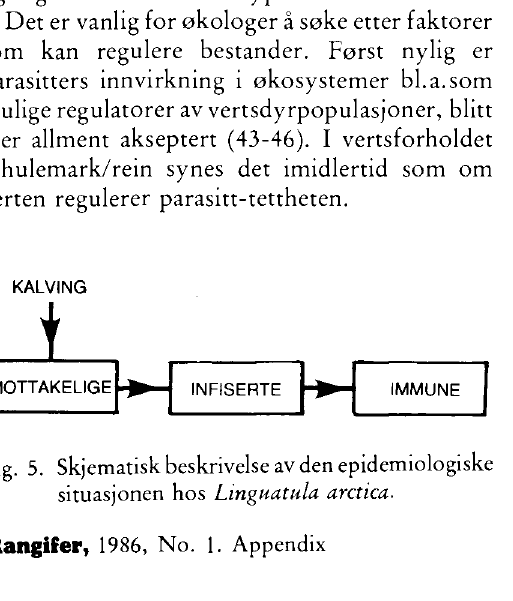
Fig. 5. Skjematisk beskrivelse av den epidemiologiske situasjonen hos Linguatula